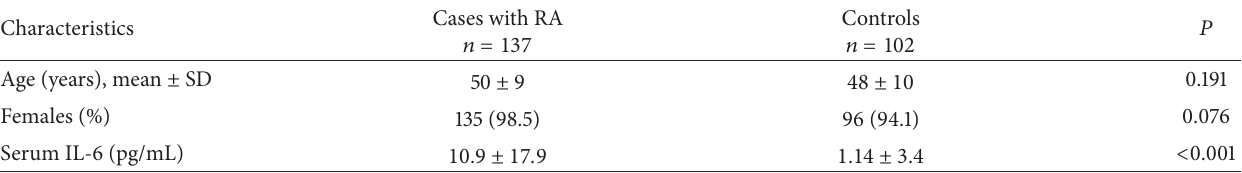
Table 1: Comparison in selected characteristics between patients with rheumatoid arthritis and healthy controls. Characteristics